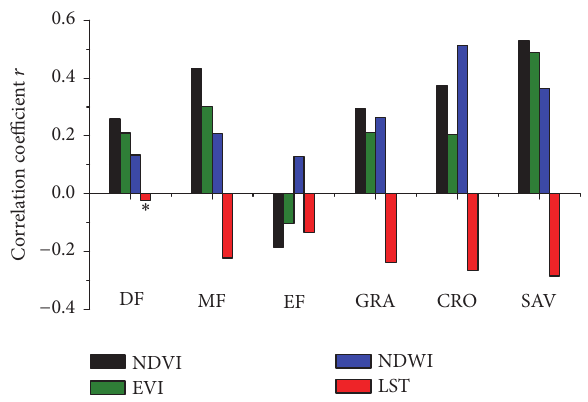
Figure 7: Correlation coefficients between monthly DSI values and the standardized anomalies of NDVI, EVI, NDWI, and LST in vegetated areas, which suffered from the 2009/2010 drought for different plant function types. 𝑝 value < 0.01, except for those marked with an asterisk ( ∗ ). DF = deciduous forest; MF = mixed forests; EF = evergreen forest; GRA = grasslands; CRO = croplands; SAV =